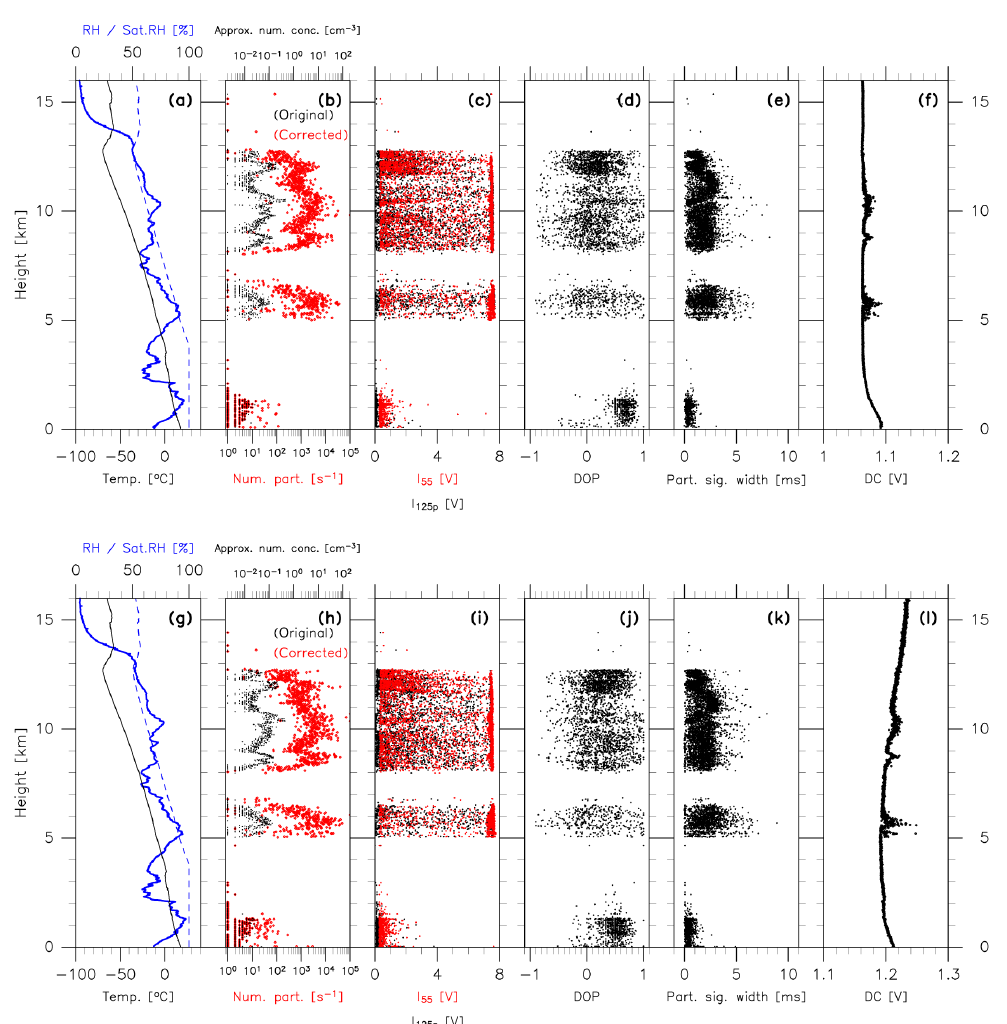
Figure 3. Results from a flight of two CPSs on the same 600g balloon at Moriya, Japan, launched at 18:07LT on 18 March 2013. Top panels (a–f) show data taken from the CPS with the configuration shown in Fig. 1 and bottom panels (g–l) from the PS2-type CPS (see the last paragraph of Sect. 2.1). Vertical profiles are shown of (a, g) temperature (black), RH (blue solid), and ice saturation RH (dashed blue) from the RS-06G radiosondes; (b, h) number of particles counted per second (and number concentration assuming 5ms − 1 flow speed), original in black and corrected (see text for details) in red; (c, i) particle output voltages I 55 (red) and I 125p (black); (d, j) the degree of polarization (DOP) (not calculated when I 55 is greater than 7V; see text); (e, k) particle signal width in ms; and (f, l) the DC component from the detector no. 1